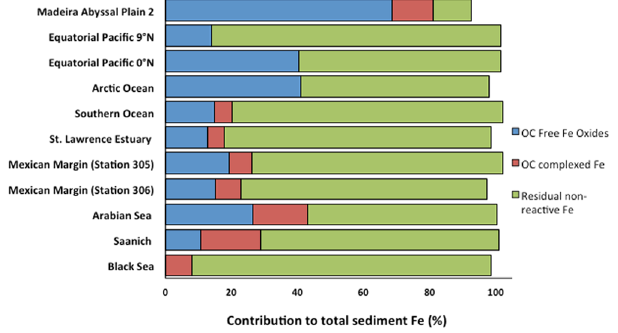
Figure 4. Iron K-edge XANES linear combination fitting results showing the OC-free iron oxides (blue), OC- complexed reactive iron (brown), and residual sediment iron (green) contributions to the total sediment Fe